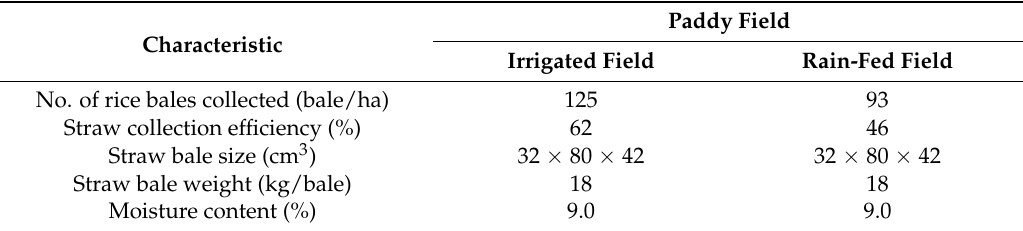
Table 4. Characteristics of rice bales from the baling